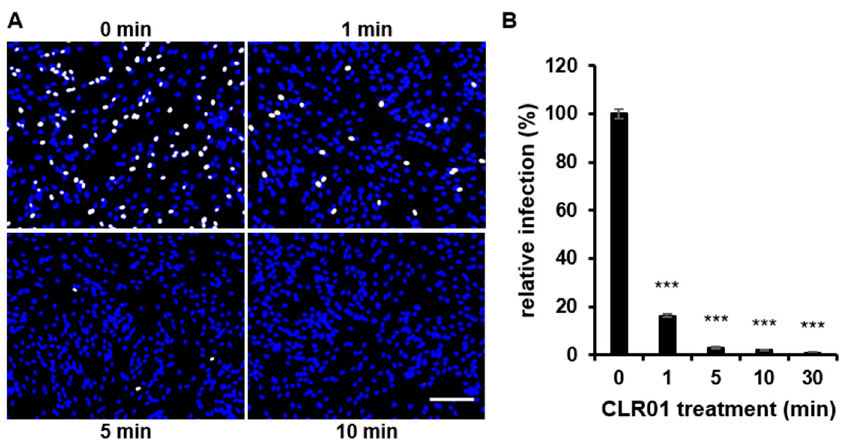
Figure 4. CLR01 rapidly inactivates HCMV particles. Cell-free virus particles of HCMV (strain TB40/E) were incubated with 50 µM CLR01 for indicated times at 37 °C prior to inactivation of CLR01 by adding medium containing fetal calf serum (FCS; final concentration 20%) and infection of human fibroblasts with these mixtures. Infection was determined after detection of HCMV IE antigen by indirect immunofluorescence at 24 hpi. ( A ) Blue, DAPI-positive cells; white, HCMV-positive cells. Scale bar is 200 µm. ( B ) Means ± SDs of relative infection are from the combined results of two individual experiments, each performed in triplicate. Control (0 min) was set to 100% and samples normalized accordingly. ***, p < 0.0001.